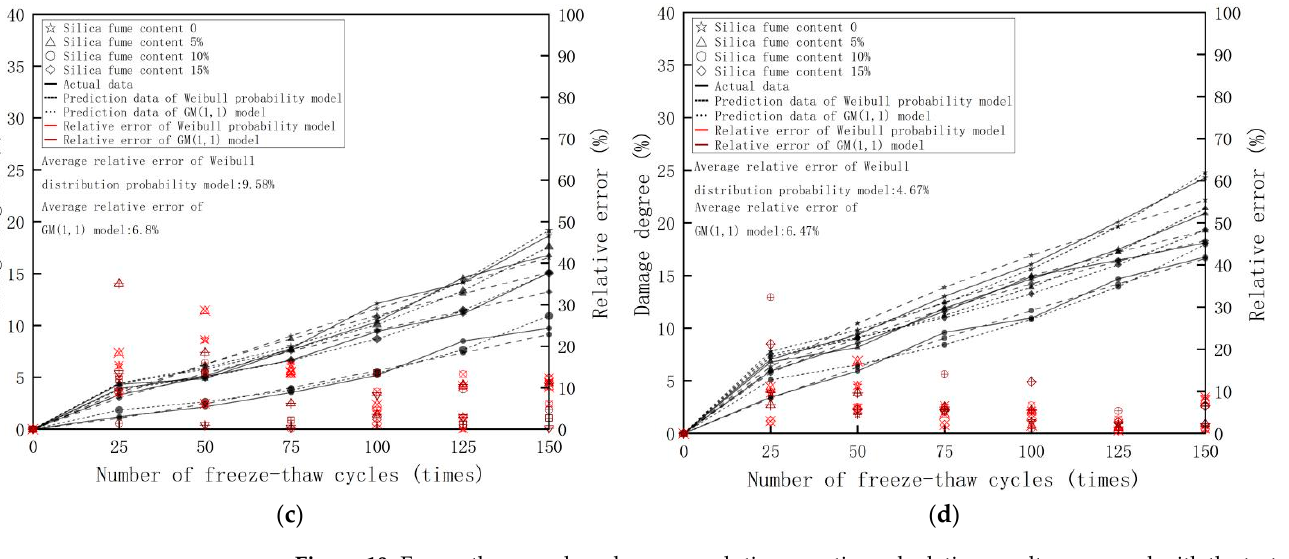
Figure 10. Freeze-thaw random damage evolution equation calculation results compared with the test curve: ( a ) Polyvinyl alcohol fiber content 0%, ( b ) Polyvinyl alcohol fiber content 0.5%, ( c ) Polyvinyl alcohol fiber content 1%, and ( d ) Polyvinyl alcohol fiber content 1.5%.